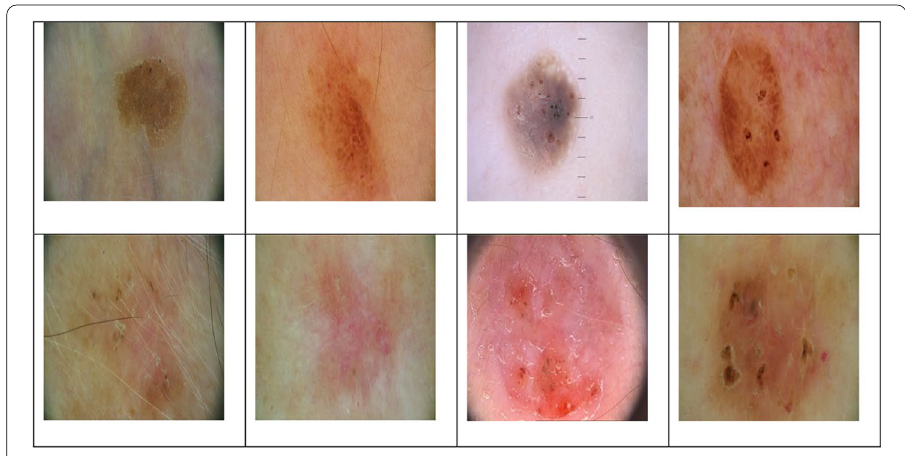
Fig. 2 The exemplary images represent both classes of images: the upper row—class of verruca seborrhoica, the lower row—basal cell carcinoma. We can also see the similarities of samples representing two opposite classes and at the same time large differences among samples belonging to the same